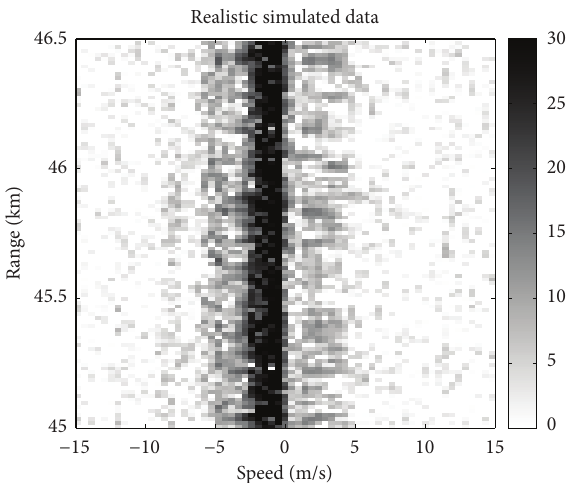
Figure 5: Range-Doppler map showing the performance of the adaptive processing on error-free data simulated data.